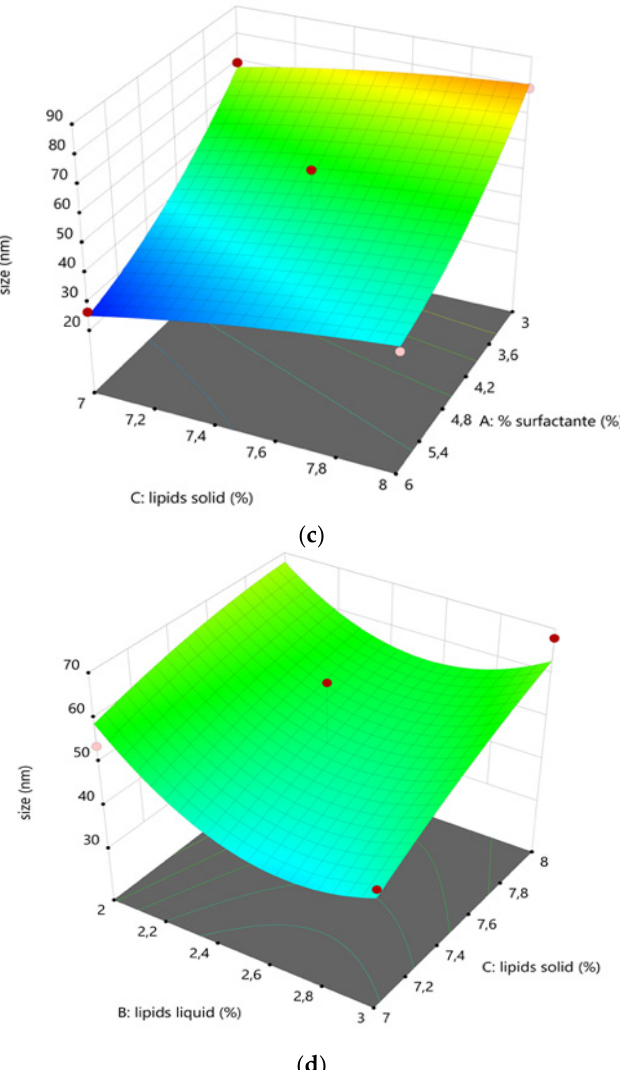
Figure 1. Pareto chart ( a ) and three-dimensional response surface plots showing the effect of ( b ) the concentration of liquid lipid and surfactant, ( c ) the concentration of surfactant and solid lipid and ( d ) the concentration of liquid lipid and solid lipid on nanostructured lipid carriers (NLC) particle size, respectively.